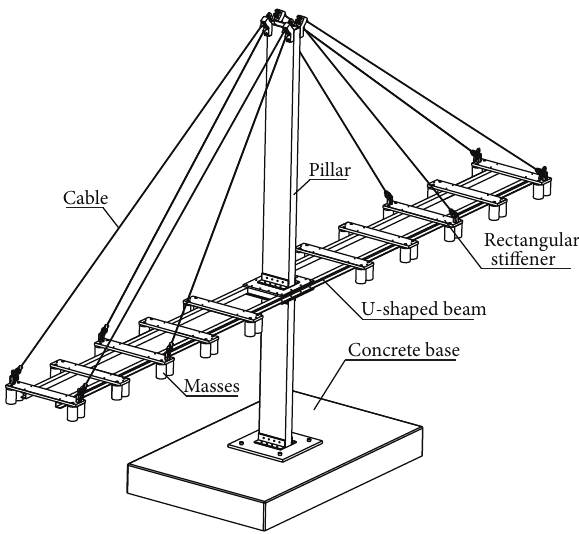
Figure 1: Description of the main components of the bridge.